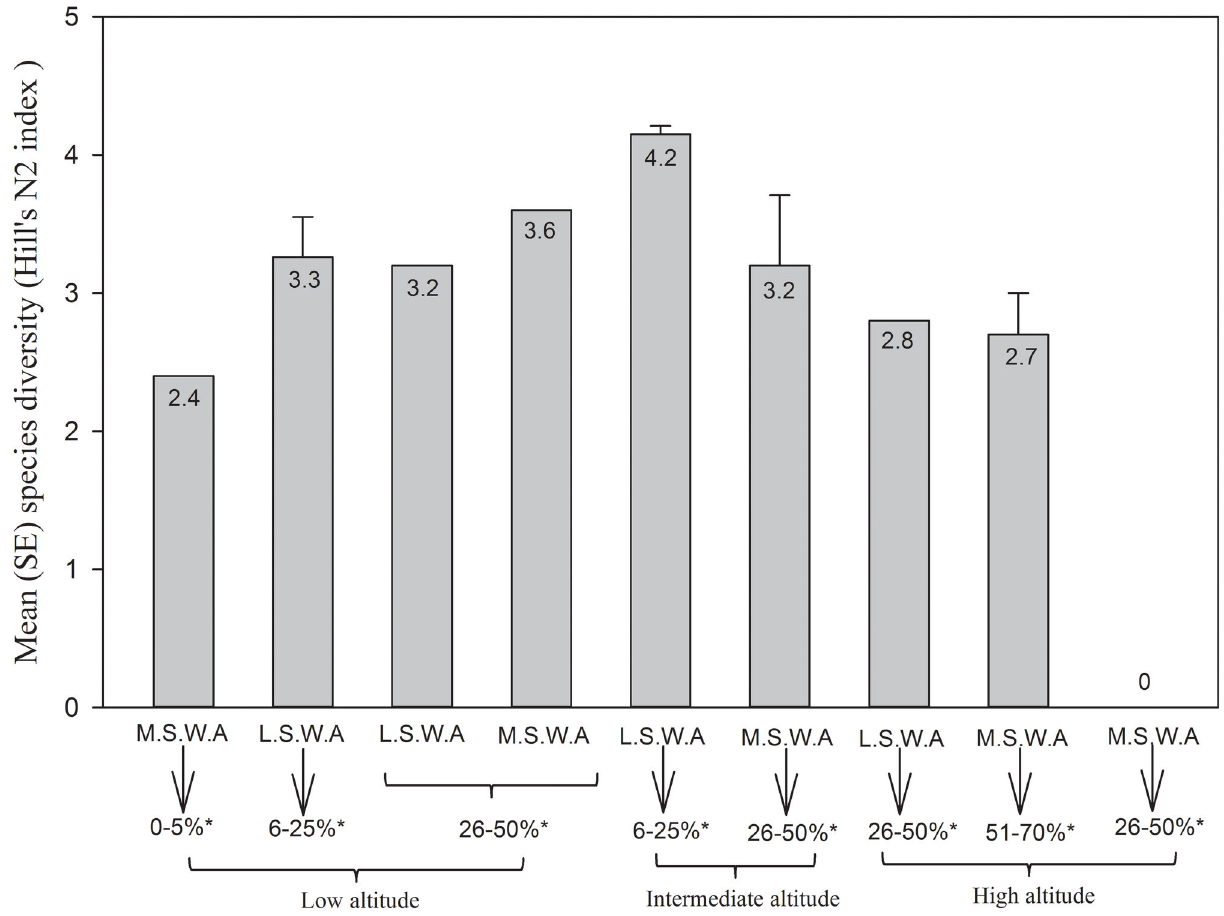
Figure 4. Pattern of lizard species diversity in relation to soil water absorption (S.W.A), overall plant density (percentage with star) and elevation in the Qom Province of Iran. Low soil water absorption (L.S.W.A) <24.1, medium soil water absorption (M.S.W.A) >24.1. Plant density and elevation categories are same as Figure 2.